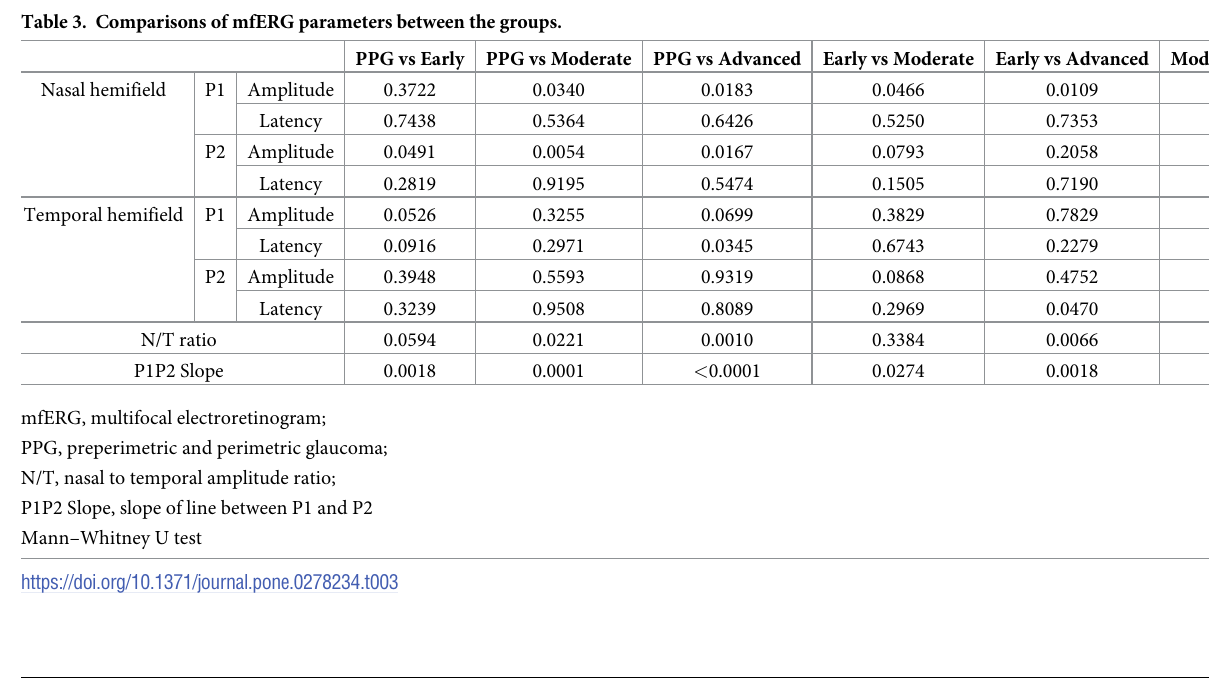
The amplitude of P2 in the nasal hemifield was significantly smaller in all glaucoma groups than in the normal group except in the PPG group ( P = 0.0074, P = 0.0006, and P = 0.0046, respectively, Table 2). In addition, the P2 amplitude was significantly smaller in the Early, Moderate, and Advanced groups than in the PPG group ( P = 0.0491, P = 0.0054, and P = 0.0167, respectively, Table 3).